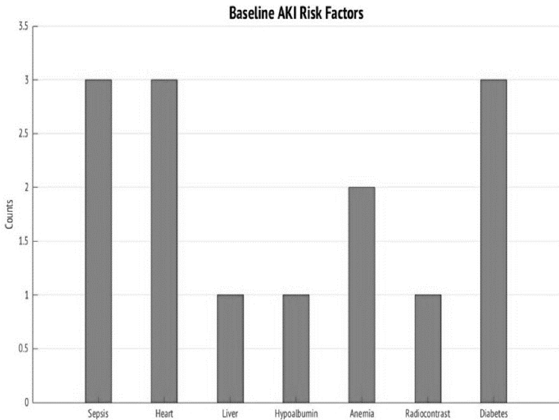
Figure 2. Counts of AKI Risk Factors at Baseline. This figure demonstrates the most frequent counts of AKI risk factors at baseline for V-AKI cases.